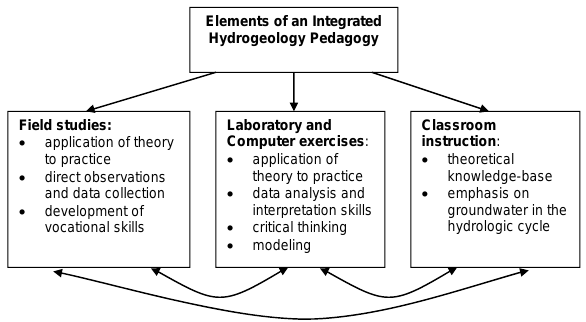
Fig. 4. The elements of an integrated hydrogeology pedagogy can Figure 4: The elements of an integrated hydrogeology pedagogy can be balanced in an 587 iterative loop so that each element supports other elements. 588 be balanced in an iterative loop, so that each element supports other 589 590 591